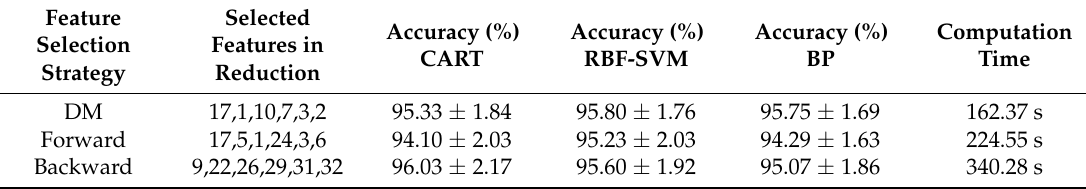
Table 2. Performance comparison of different feature selection strategies (NES39).